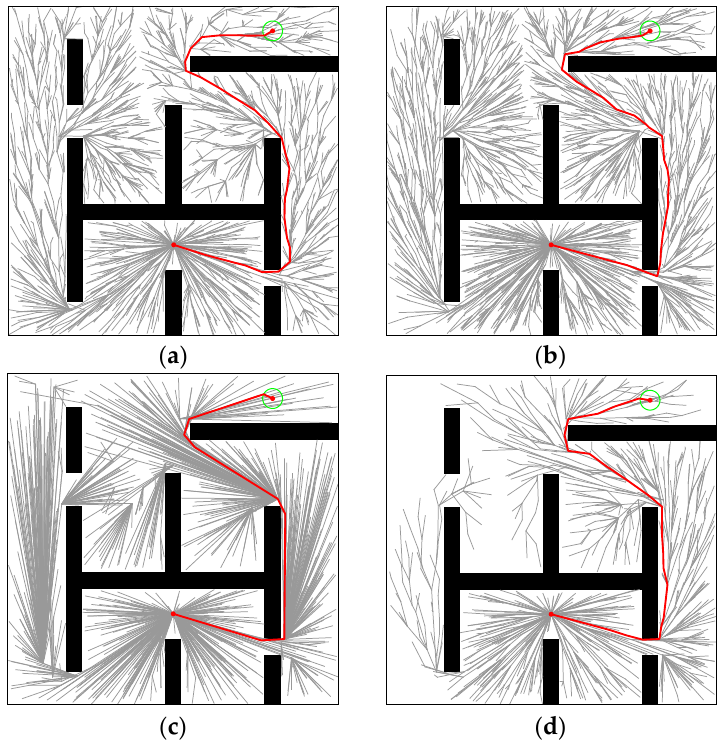
Figure 15. Performance of the four algorithms in the Maze. ( a ) RRT*. ( b ) Informed-RRT*. ( c ) Q-RRT*. ( d ) M-RRT*. (Red line: approximate optimal path, green circle: goal region.)